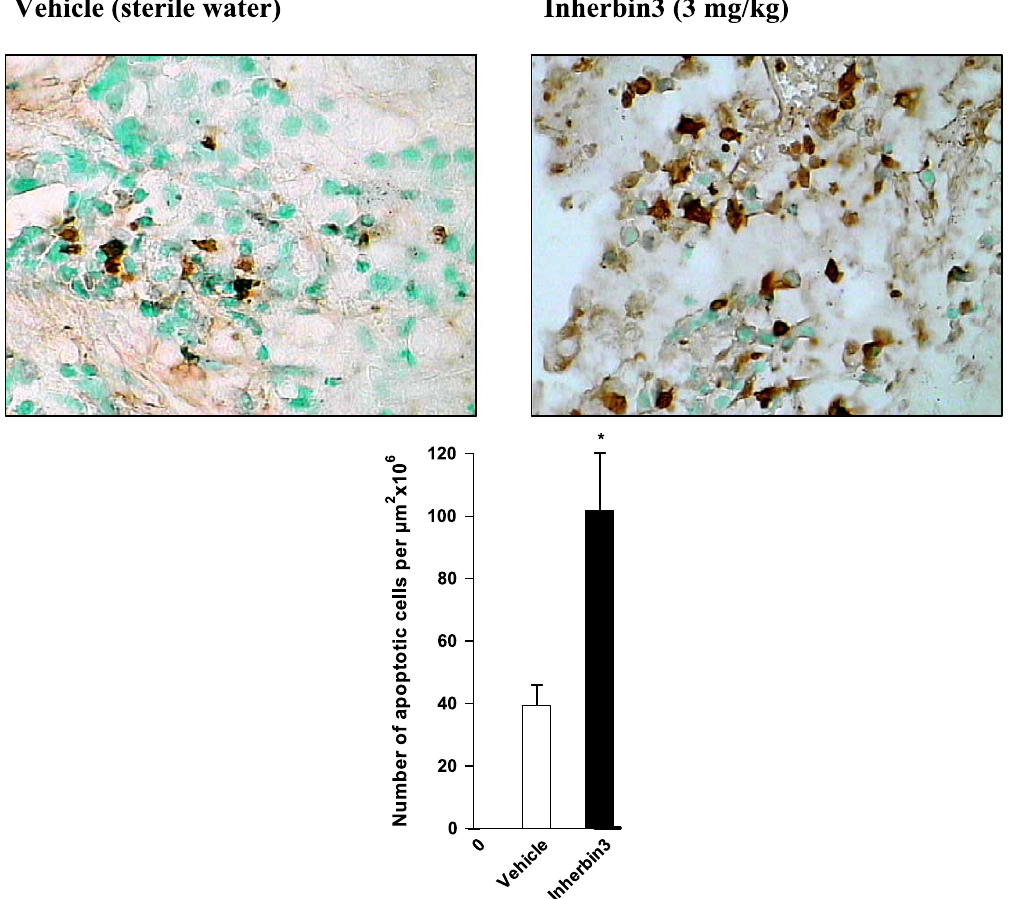
Fig. 8. Effect of Inherbin3 on cell apoptosis in a SCID mouse xenograft model with the NSCLC A549 cell line. Tumors from the groups treated with vehicle (sterile water) or 3 mg/kg Inherbin3 (experiment 1, shown in Fig. 7A) were analyzed. Three 10 µm-thick sections of each tumor were stained with TUNEL to visualize apoptotic cells. The number of TUNEL-positive cells was counted for each section. ∗ p < 0 . 05, compared with vehicle-treated tumors (control) (Student’s paired t